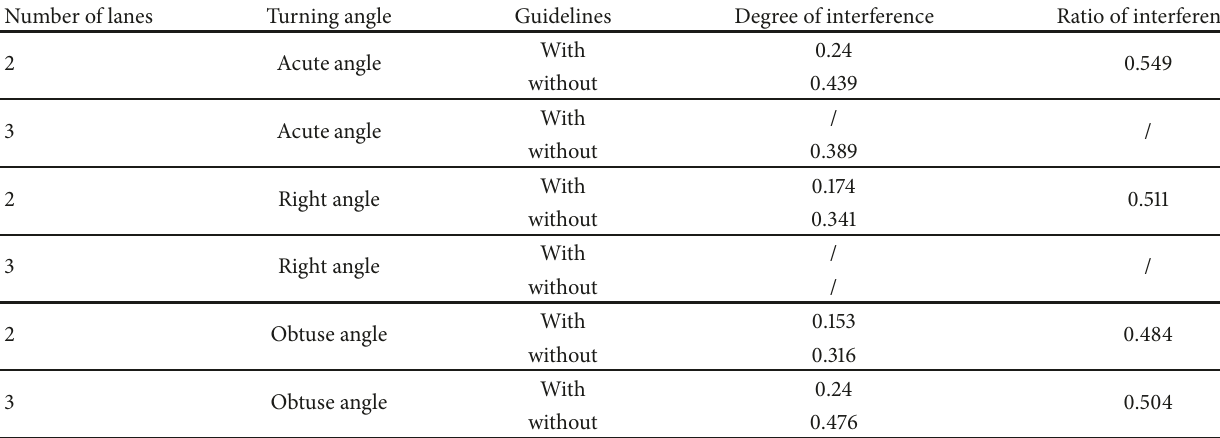
Table 9: Degree of interference for left-turns.